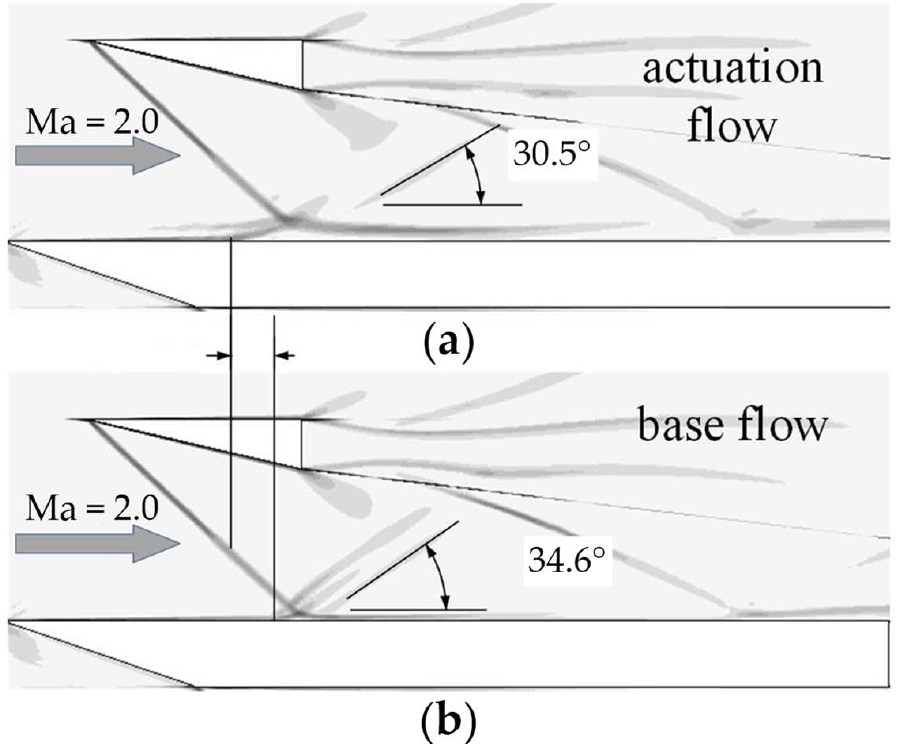
Figure 20. Numerical schlieren at z = 0 cross section: ( a ) 10 kHz actuation flow field; ( b ) base flow field. The flow field at different cross sections was also analyzed. Figure 21a,b represents the numerical schlieren at the z = 0.025 m cross section and shows that the array actuation effectively weakened the intensity of the separation shock wave. Figure 21c,d show the numerical schlieren at the z = 0.054 m cross sections at the edge of the plate. The results show that the structure and intensity of the separation shock wave were not significantly affected after the actuation was applied. Hence, it can be concluded that actuation in the flow direction can hardly exert a full, spanwise control effect. In subsequent studies, the coupled layout of actuators in spanwise and flow directions should be considered to achieve a better control